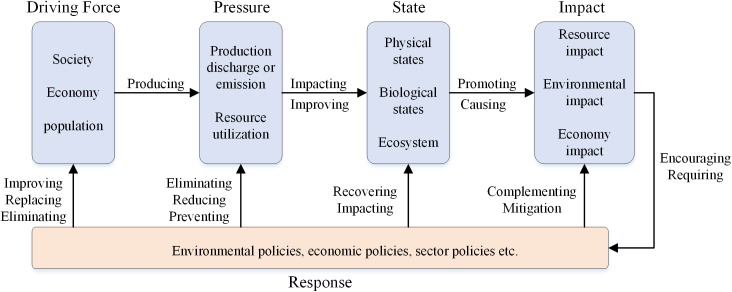
DPSIR model and its inner connections [35].